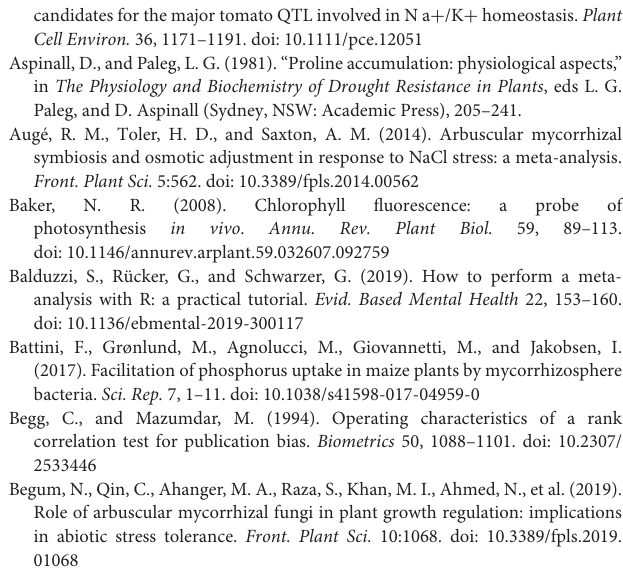
Supplementary Figure 1 | Pie chart showing frequency (%) of occurrences of plant (A) and fungal (B) species in the whole metaanalysis dataset in current study. Supplementary Table 1 | List of papers used in metanalysis. Supplementary Table 2 | Metadata obtained and used for analyses in the current